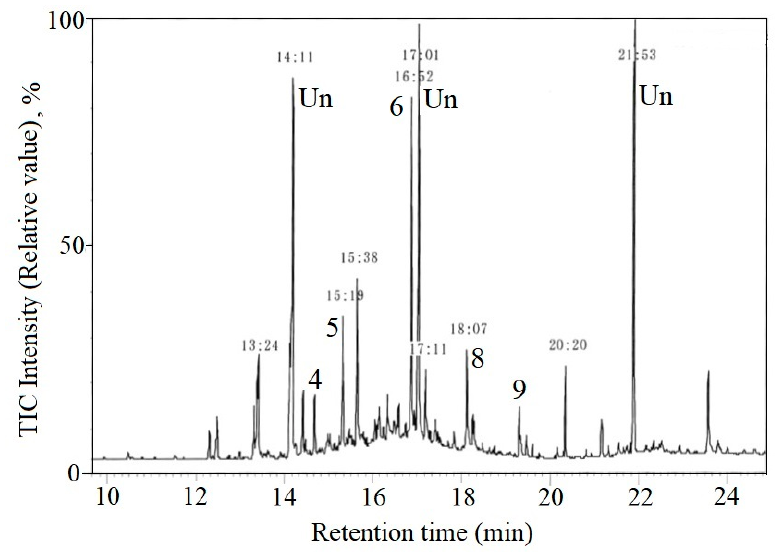
Figure 5. TIM-GC / MS chromatograms of the sample extracted from pebble by Showa base, Antarctic Figure 5. TIM-GC/MS chromatograms of the sample extracted from pebble by Showa base, Antarctic continent, 60 ◦ 00 (cid:48) S, 39 ◦ 35 (cid:48) E, continent, 60°00 ′ S, 39°35 ′ E, 1984.